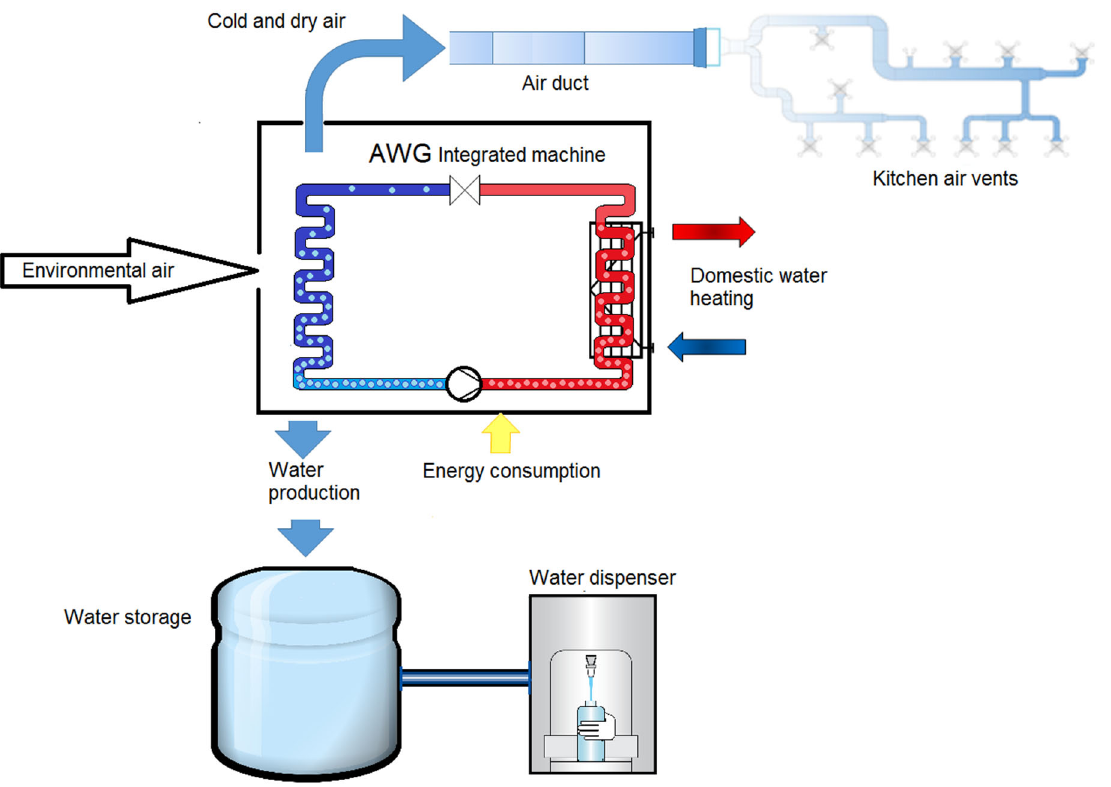
Figure 3. AWG integrated machine useful effects employment scheme.